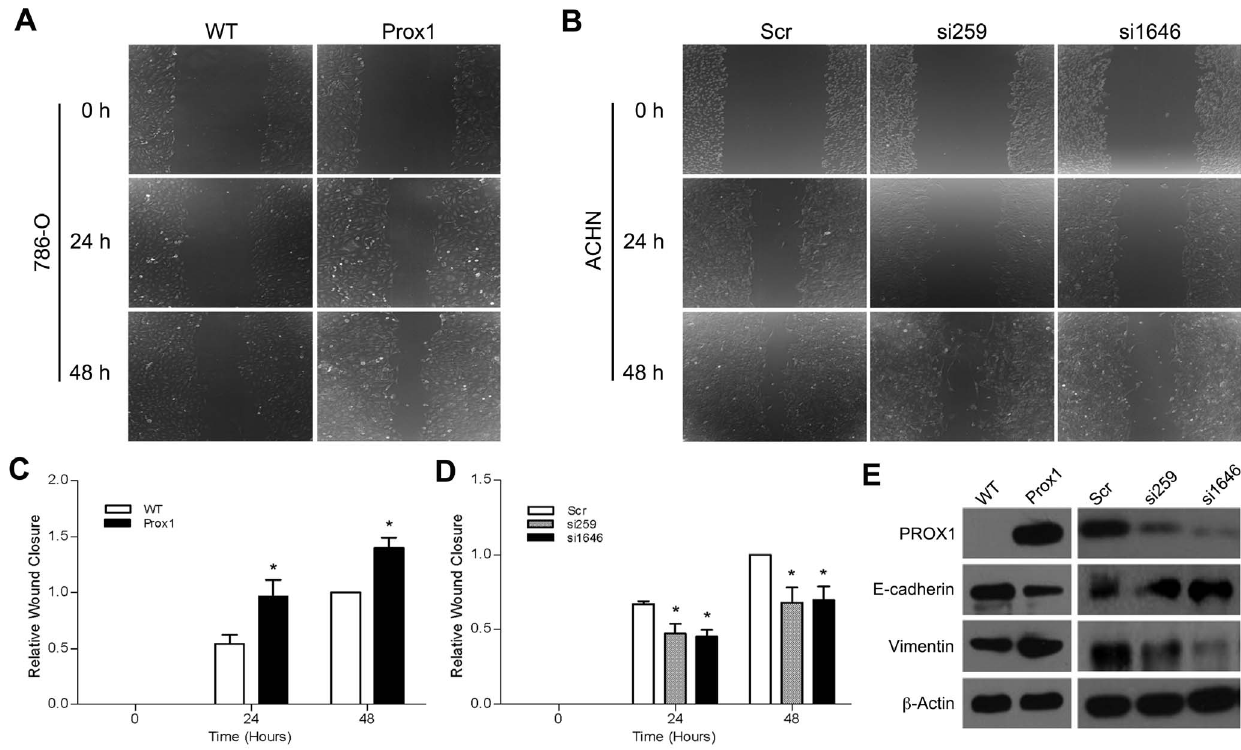
Figure 6. PROX1 enhances cell wound closure invitro and regulates E-cadherin and vimentin protein expression. (a) 786-O cells were infected with Lenti-PROX1 for 72 h in six-well plates. The cell layer was scratched in each well to create a cleared line. The cells were then incubated in fresh media. (b) The same experiment was performed in ACHN cells infected with Lenti-siSCR, Lenti-si259, or Lenti-si1646. (c,d) The wound width was calculated using Image-Pro Plus software, and the relative wound closure was calculated, setting wound closure of the control condition at 48 h as 1. (e) Western blot analysis of PROX1, E-cadherin, and vimentin protein expression in 786-O and ACHN cells infected with lentiviruses for 72 h. * P , 0.001.